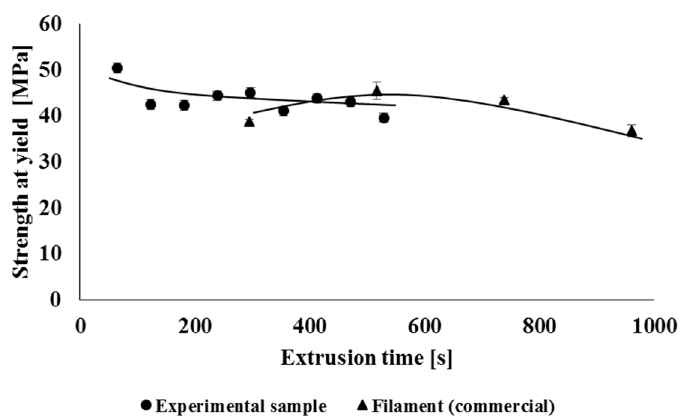
Figure 15. Dependence of strength at yield on the total processing time of the polymeric material.